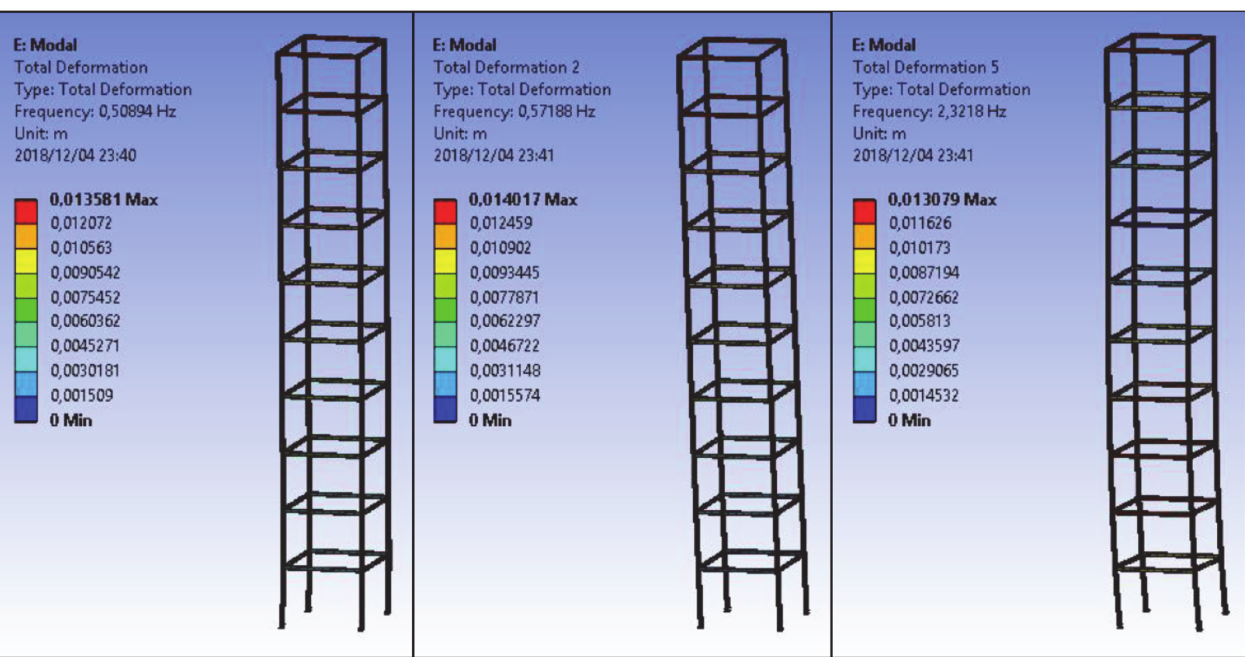
Figure 10: Mode Shapes 1, 2 and 5 of the Auxetic